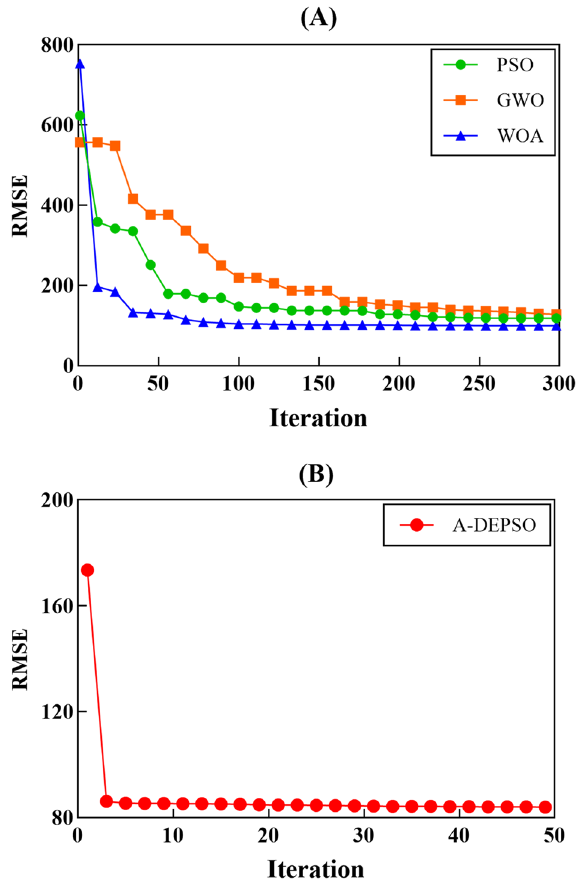
Figure 17. Convergence graphs of ( A ) PSO, GWO, WOA, and ( B ) A-DEPSO.